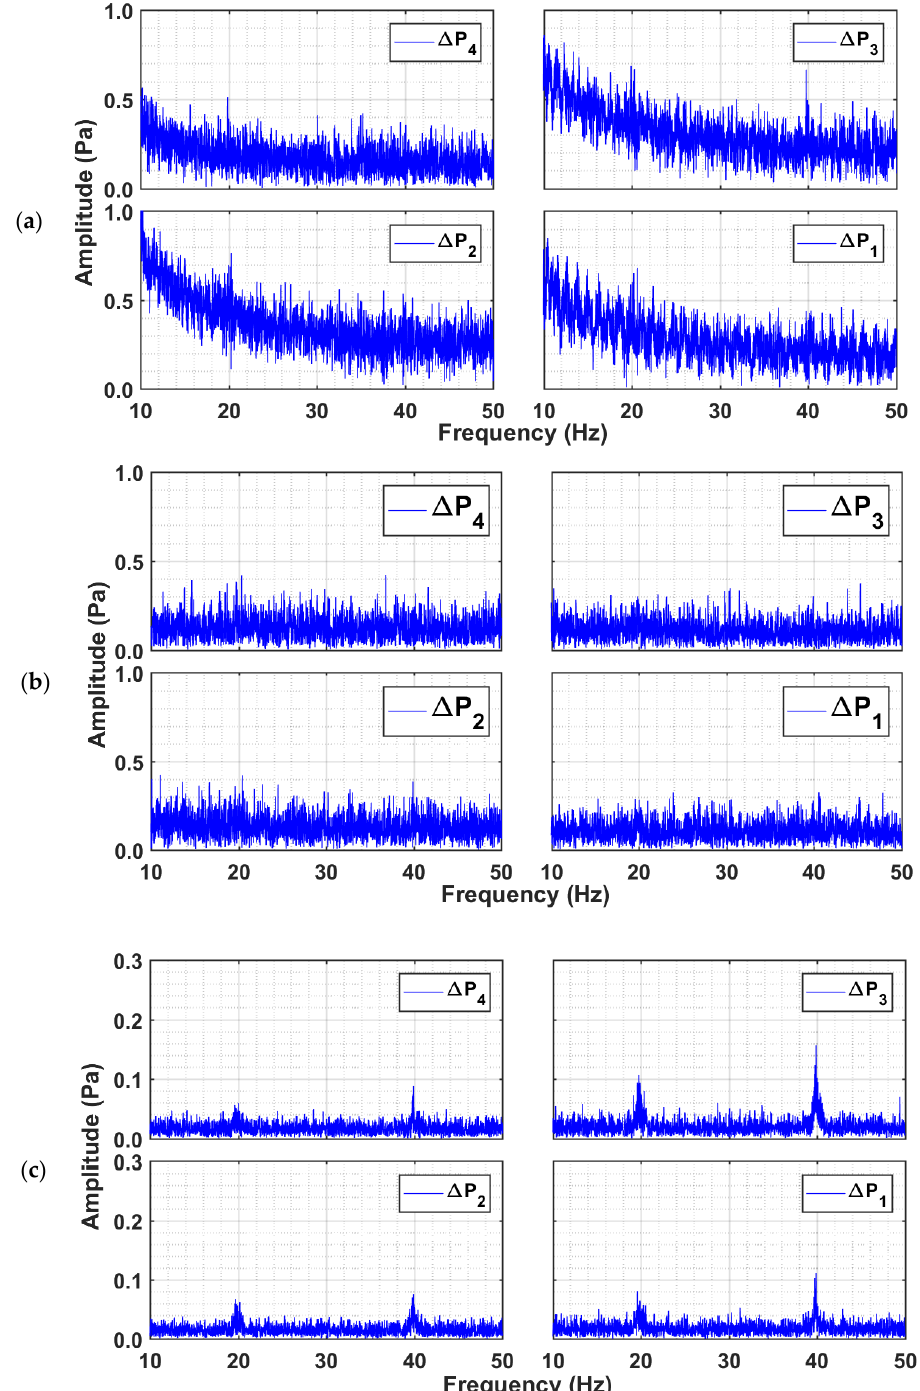
Figure 9. Power spectral analysis at low frequencies (10–50 Hz) of pressure transients in different bed regions of the collapsing bed at U mf and bed height H of ( a ) glass beads, ( b ) titania, and ( c ) nanosilica.